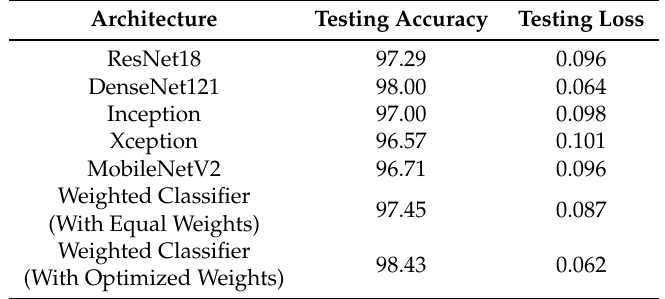
Figure 8. ( a ) Training accuracy and training loss curves for different architectures over the training dataset while the models were trained for 25 epochs, ( b ) Zoom-in version of ( a ). Table 4. Final testing accuracy and testing loss achieved by all the architectures and the weighted classifier.